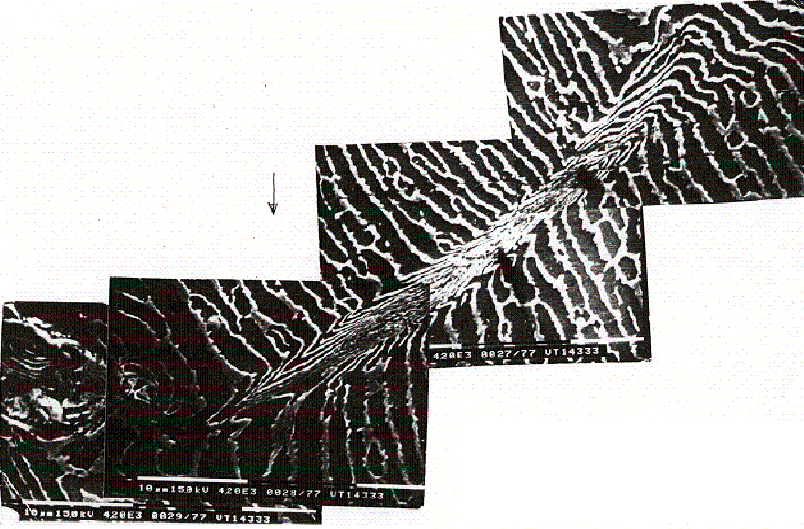
Figure 4. Transition of shear band in shock-deformed VT14 titanium alloy target into rotation.